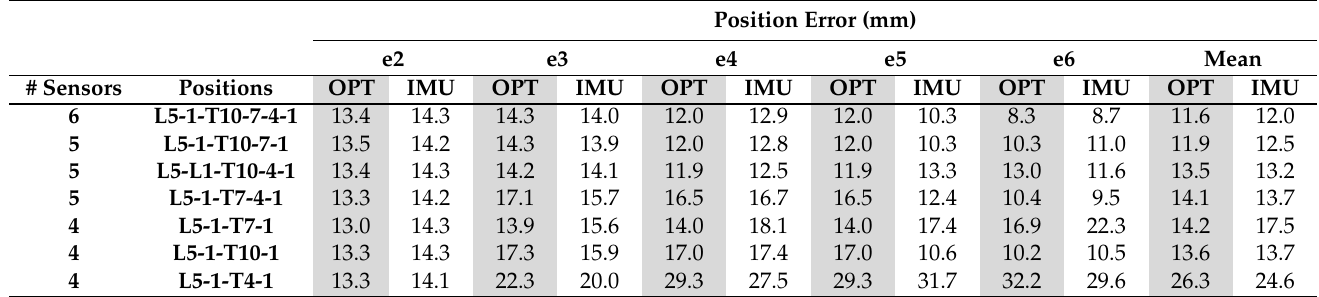
Figure 7. ( a ) Spine multibody model; ( b ) Detail and meaning of the colored dots. Table 1. Position error, in mm, between estimated (TPM-OPT or TPM-IMU) and measured (direct measurement with optical system) sensor